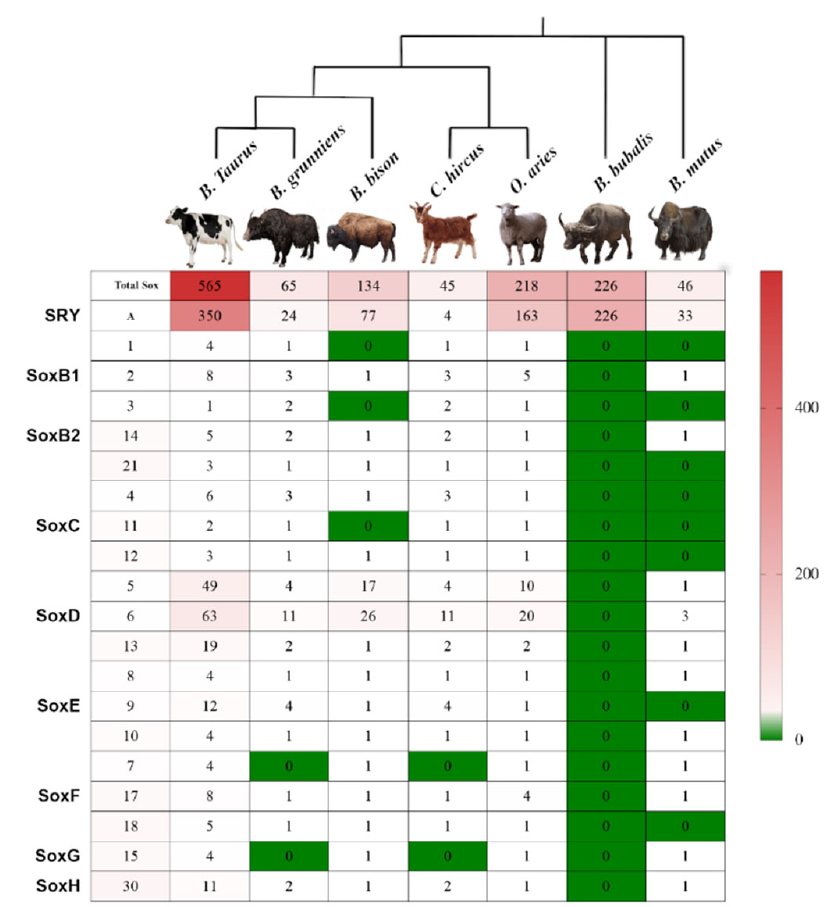
Figure 1. The phylogenetic analysis, categories, and abundance of the Sox gene family in Bovidae.